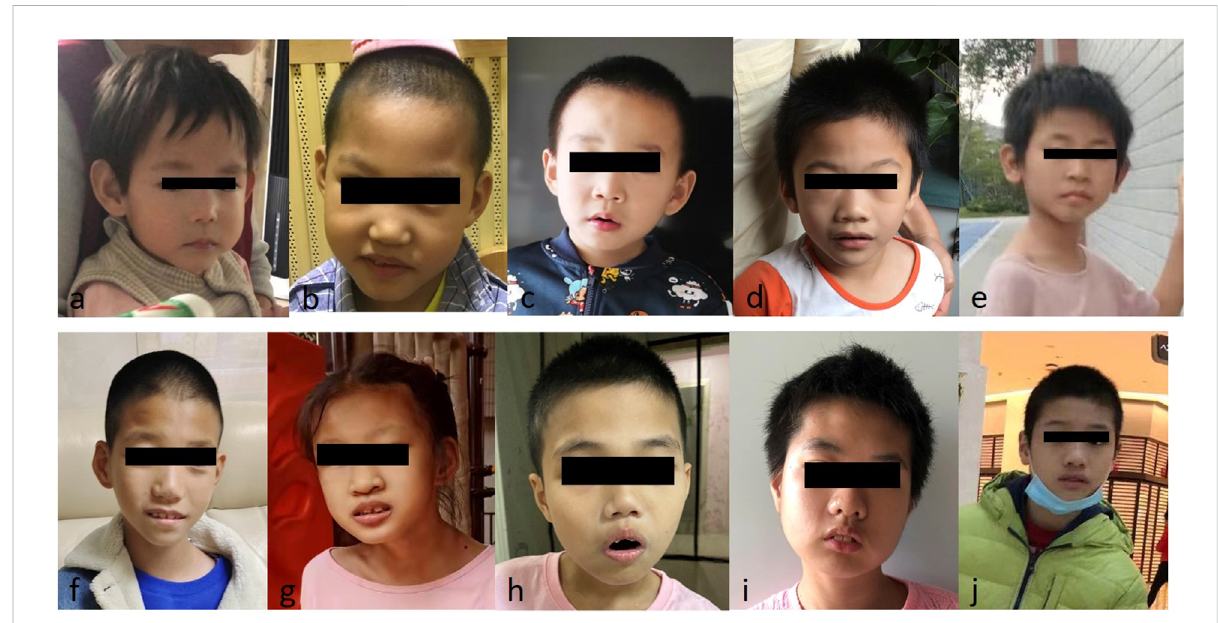
FIGURE 3 Images of patients with PMS. (A) Case 9, 2 years old; (B) case 3, 4 years old; (C) case 14, 6 years old; (D) case 16, 7 years old; (E) case 15, 8 years old; (F) case13,9 yearsold; (G) case12,10 yearsold; (H) case20,11 yearsold; (I) case10,13 yearsold;and (J) case21,13 yearsold. (H,J) Patientswith pathogenicvariantsofthe SHANK gene;others:thepatientswith22q13deletionencompassthe SHANK3